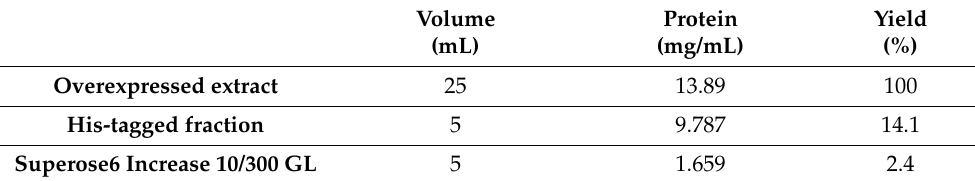
Table 3. Description of the purification steps for Lrp from Hfx. mediterranei .